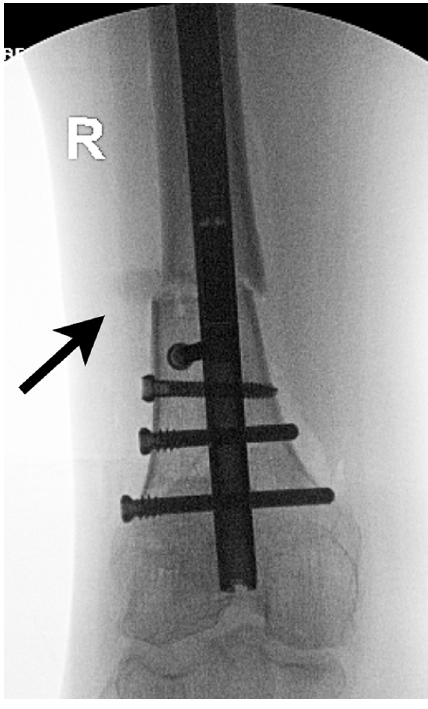
Figure 8. This intraop fluoroscopy frame shows a radio-opaque blush at the lateral aspect of the osteotomy site